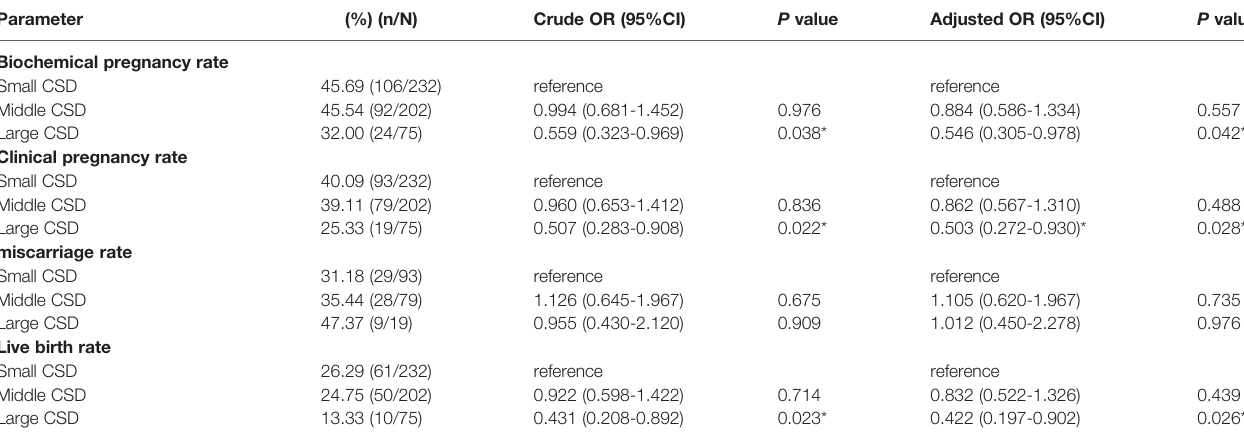
TABLE 6 | Logistic regression analysis of patients with different sizes of CSD.